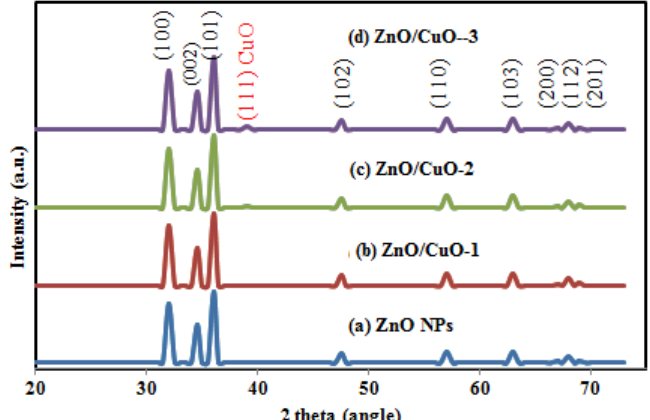
Fig.2. XRD patterns of (a) bare ZnO NPs and (b) to (d) ZnO/CuO hybrid